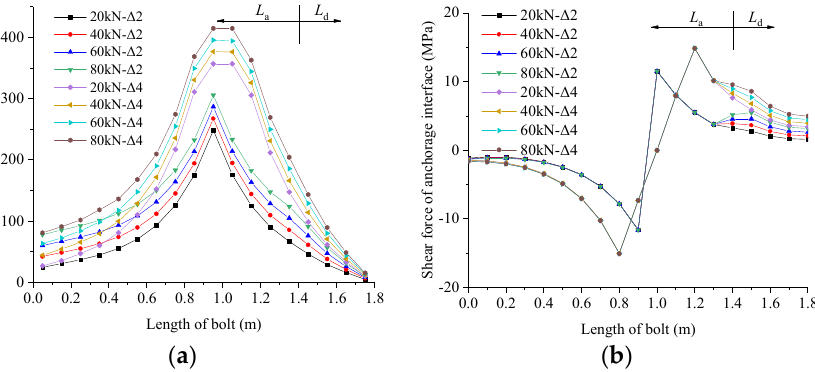
Figure 9. Simulation results of the different sizes of prestress. ( a ) Axial force of the bolt. ( b ) Shear force of the anchorage interface.